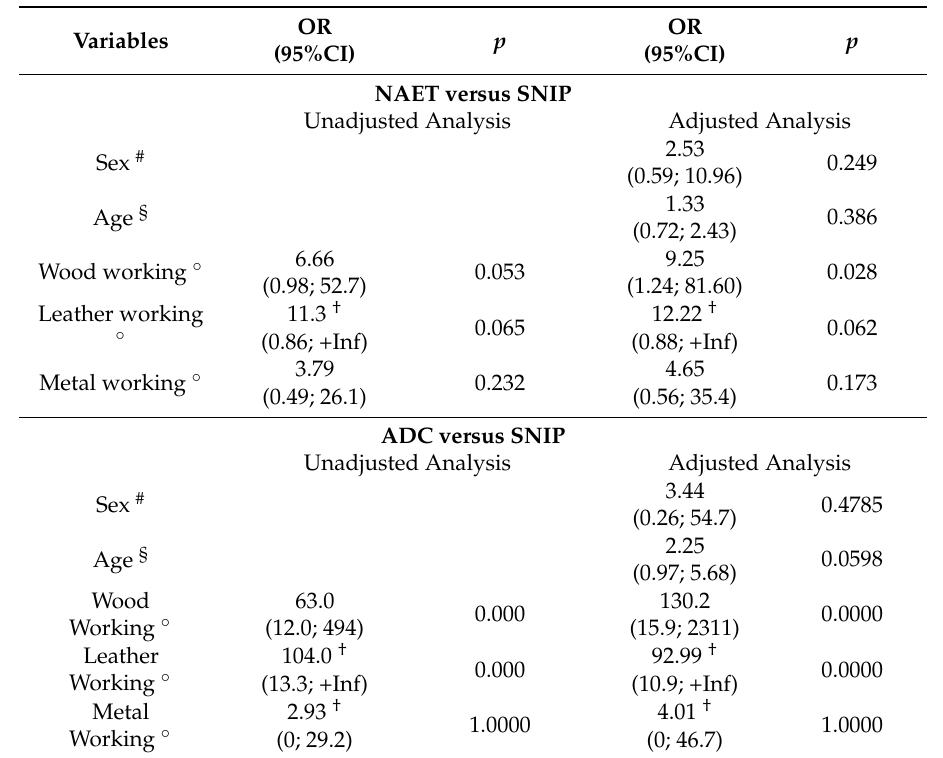
Table 3. Exact logistic regression estimating the odds ratio (OR) with a 95% confidence interval (95%CI) and two-tailed p -value ( p ) for a case-control